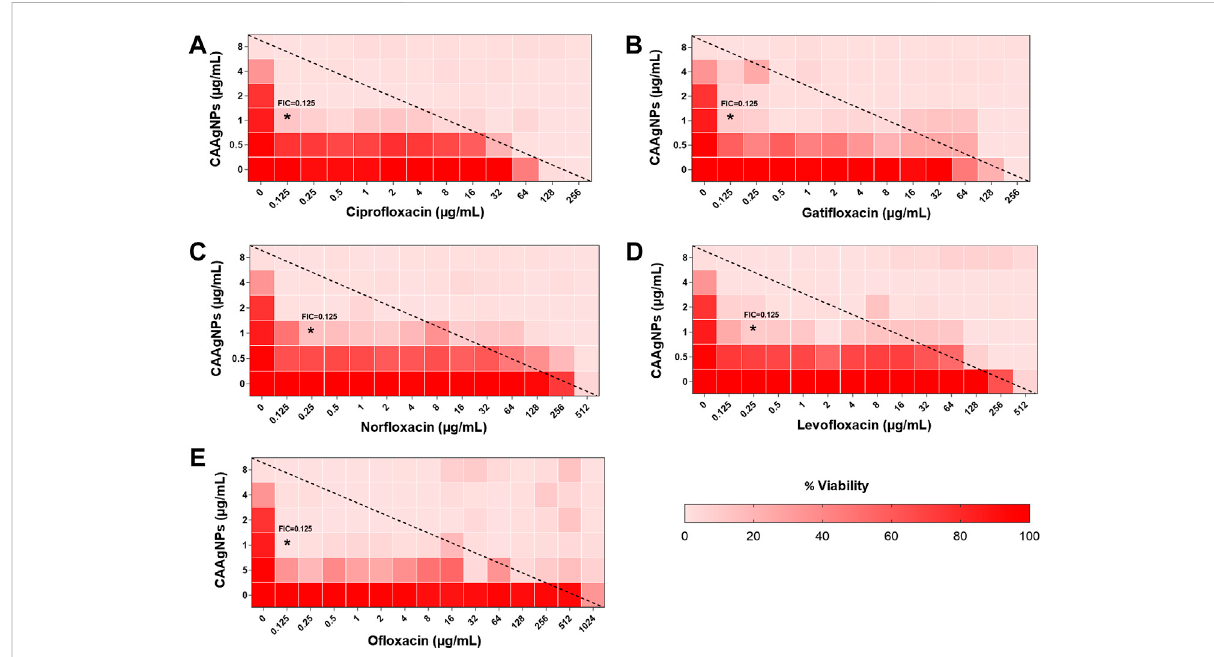
FIGURE 10 Heat plots demonstrating synergistic effect of CAAgNPs in combination with antibiotics against P. aeruginosa PAW1. Representation of normalizedvaluesofpercentviability aftertreatmentofCAAgNPs(0 – 8 μ g/ml)with (A) Cipro fl oxacin(0 – 256 μ g/ml), (B) Gati fl oxacin(0 – 256 μ g/ml), (C) Nor fl oxacin(0 – 512 μ g/ml), (D) Levo fl oxacin(0 – 512 μ g/ml)and (E) O fl oxacin(0 – 1,024 μ g/ml)respectively.Untreatedcellswithhundredpercent viability indicated by darker red boxes. Lighter red boxes indicate reduced cell viability. Dashed line passes through the MICs and “ * ” (asterisk) below it represents the FICi values suggesting a synergistic effect.